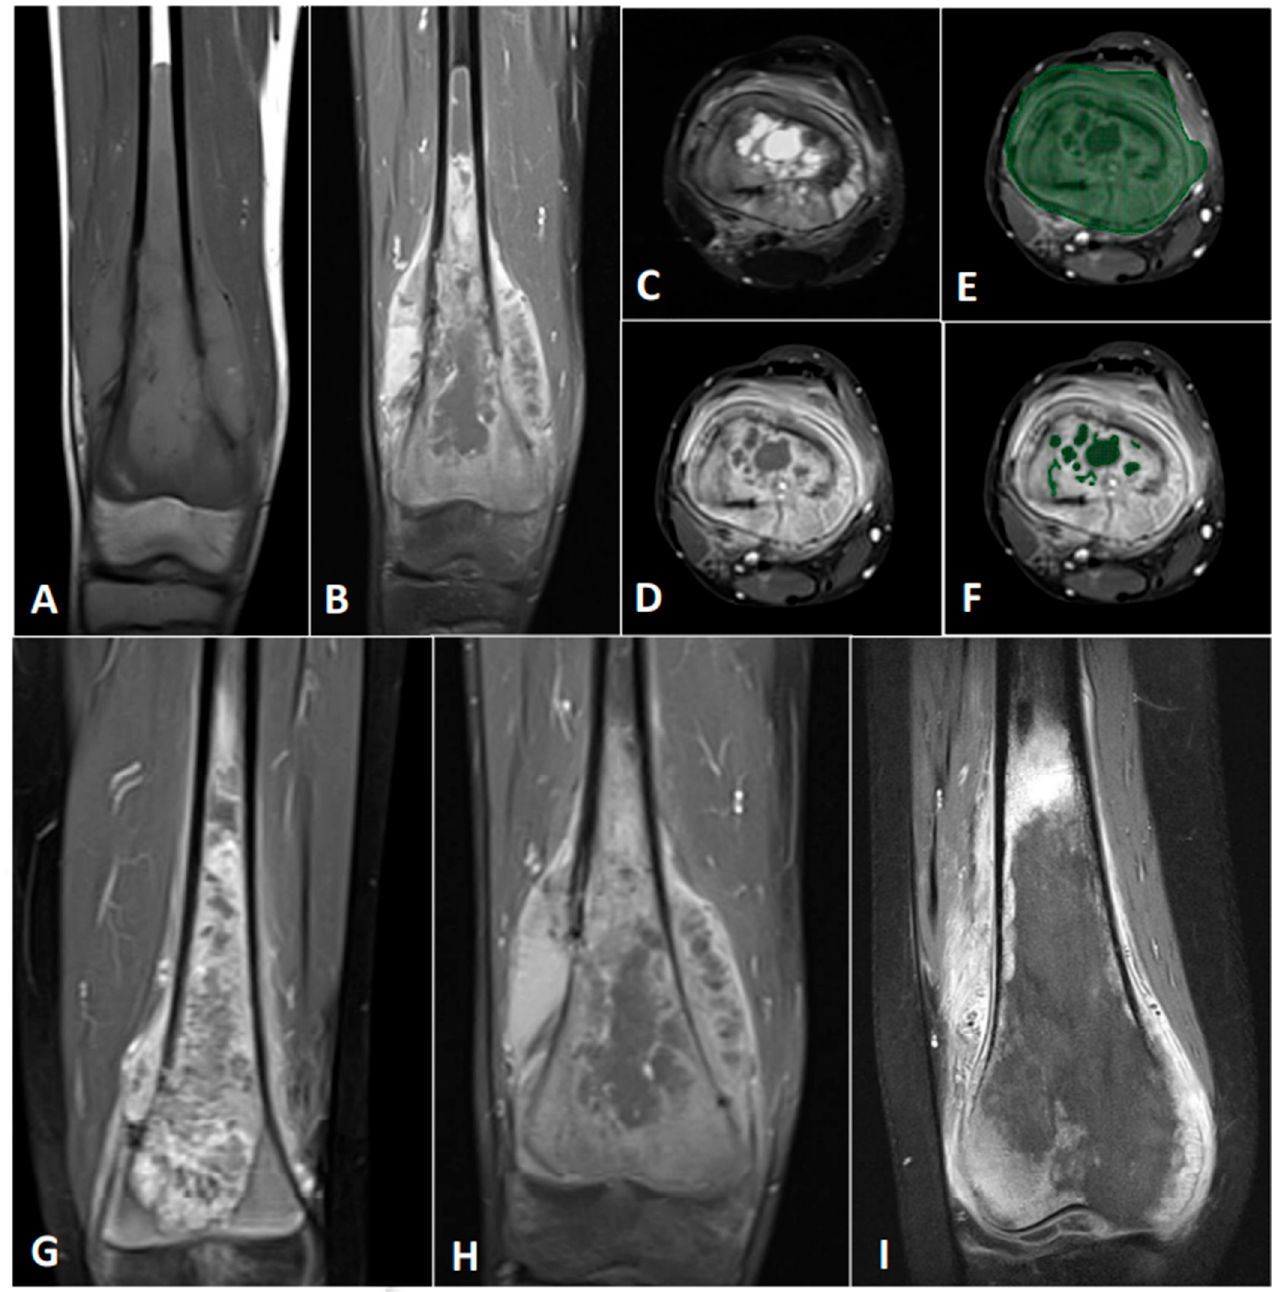
Figure 2. Magnetic resonance imaging (MRI) analyses. ( A – D ). Example of a high-grade osteosarcoma (OTS) at diagnosis in a 15-year-old patient: coronal T1 weighted image ( A ), post-contrast fat-saturated (FS) T1 weighted image ( B ), axial FS T2 weighted image ( C ) and post-contrast axial FS T1 weighted image. ( E ) Manual delineation of the tumor volume margins. ( F ) Manual delineation of intra-tumor necrotic areas. ( G – I ) Three different levels of necrosis in bottom line figures: coronal post-contrast FST1 weighted MRI images with a small proportion of necrosis ( G ), an average proportion of necrosis ( H ) and a high percentage of necrosis ( I ).